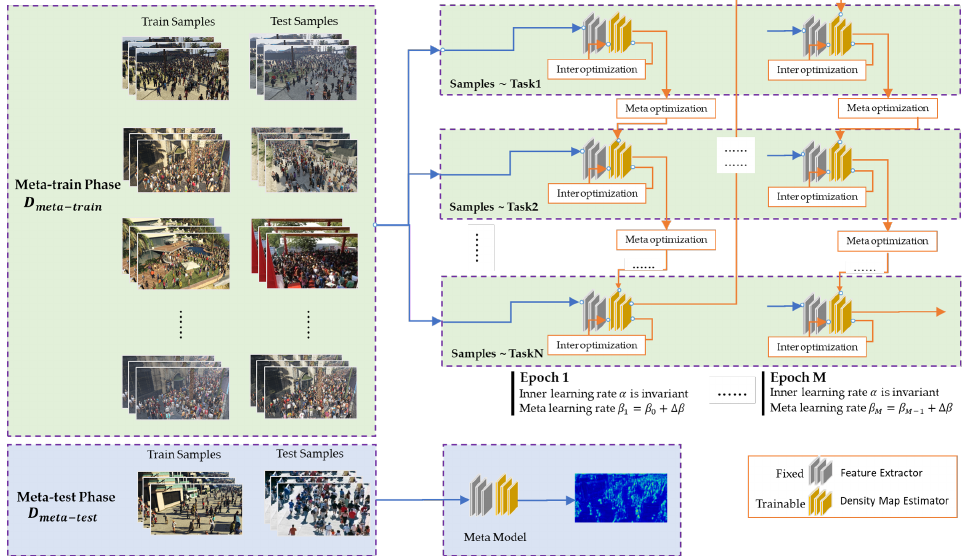
Figure 2. The details of meta-learning for the density estimator. There are two parts to optimize the model parameters: inner-optimization and meta-optimization. Inner-optimization is over each task, and the meta-optimization is across different